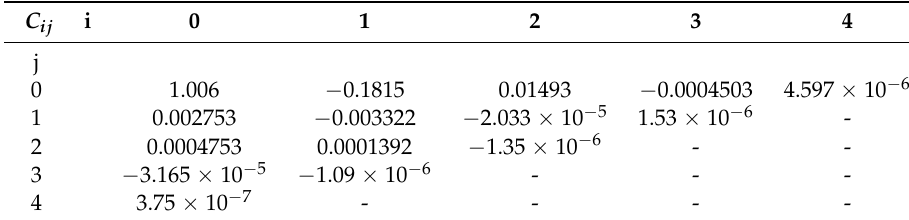
Table 7. Surface Polynomial Coefficients for Class